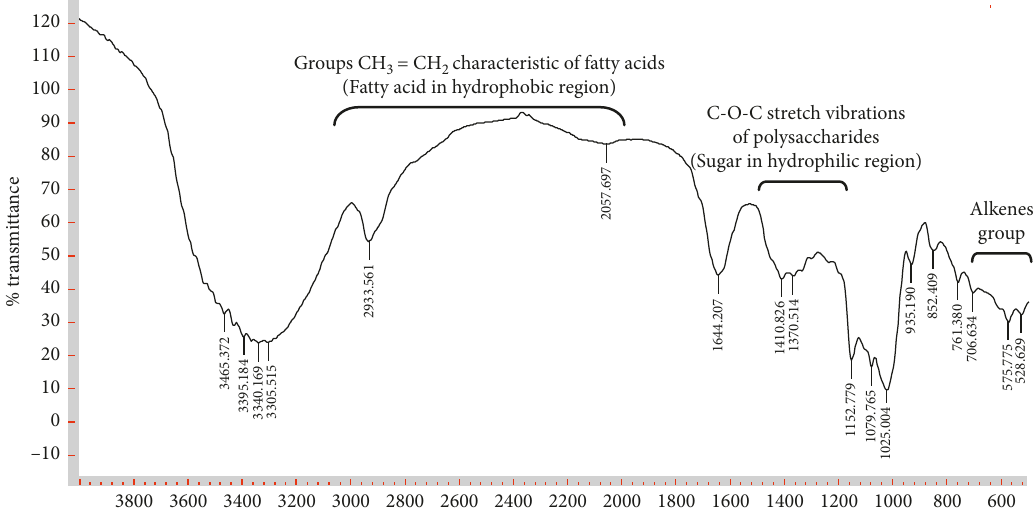
Figure 4: Infrared spectrum (FT-IR) for the structure of the glycolipid biosurfacant produced by Cunninghamella echinulata .